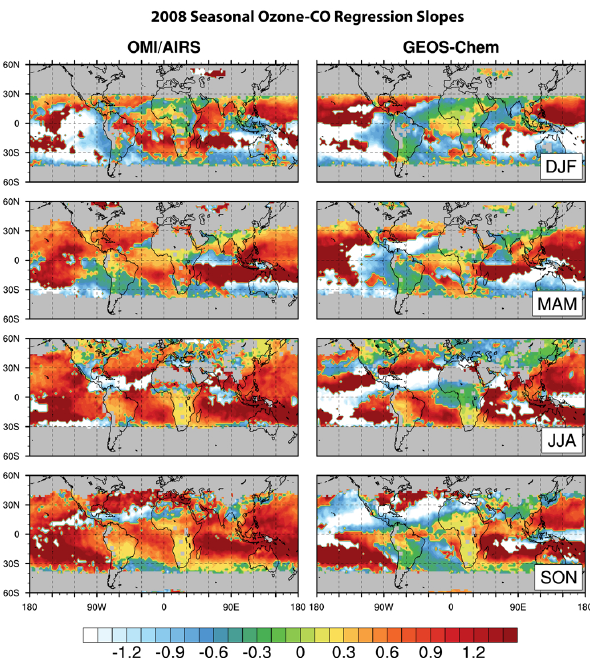
Fig. 3. Comparison of ozone–CO RMA regression slopes ( d O 3 / d CO) at 700–400hPa of the MOZAIC and OMI/AIRS ob- servations. The RMA linear fit is shown inset with bootstrap er- rors. Values are shown for all MOZAIC vertical profile locations with n >10 for individual seasons of 2006 and 2008. Complete comparison statistics are in Table S1. The station locations are W: Windhoek, Namibia; Po: Portland, USA; D: Dallas, USA;